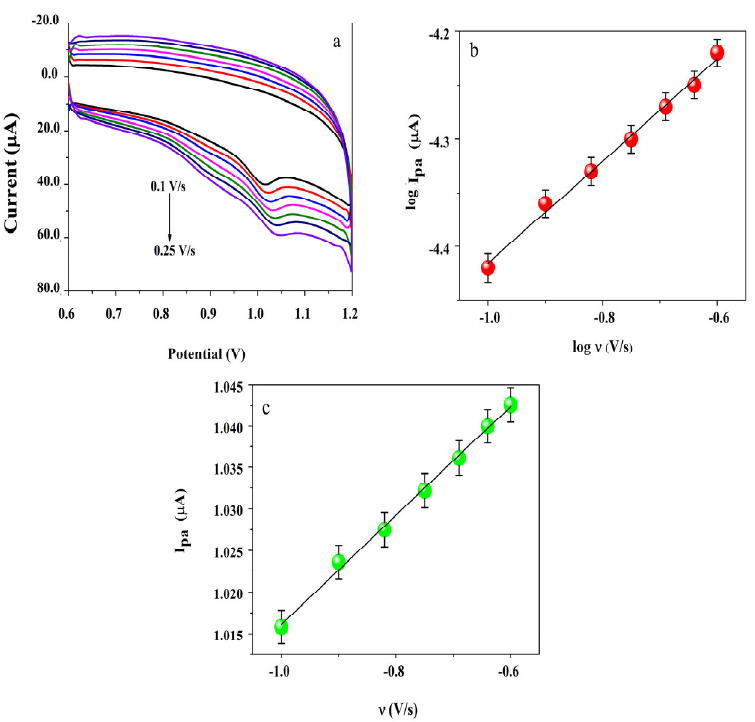
Figure 7. ( a ) CVs of 0.1 M LN at optimal pH with various scan rates (0.1–0.25 Vs − 1 ). Plots of ( b ) log I pa vs. log υ and ( c ) E pa vs. log υ .